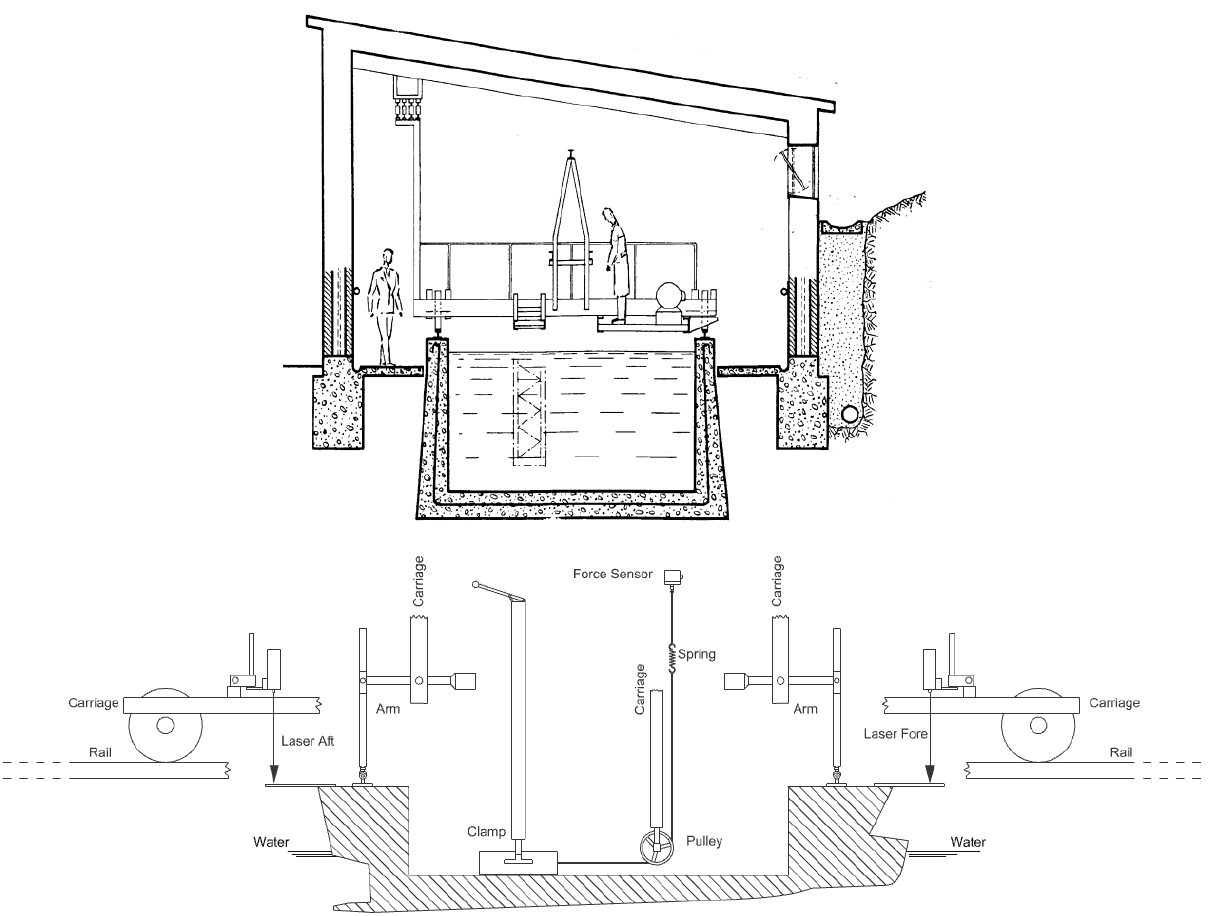
Figure 16. Transverse view of Tank at ETSIN and power test setup.